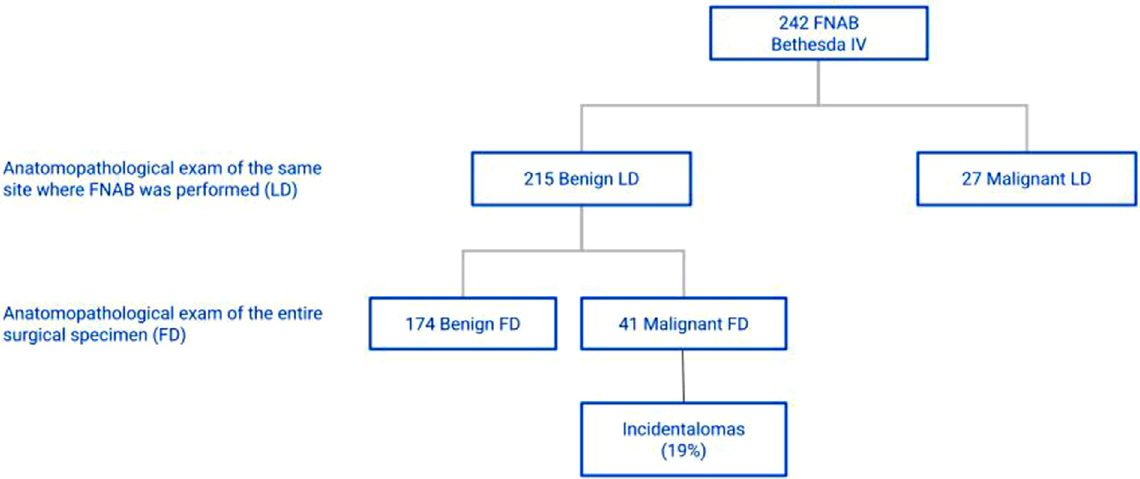
Fig. 3. Anatomopathological exams of patients categorized as Bethesda IV.